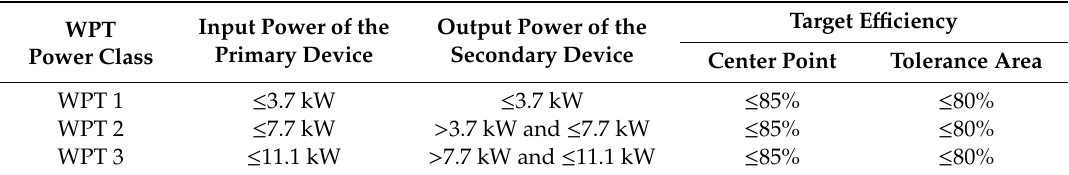
Table 1. Wireless power transfer (WPT) power classification with target e ffi ciency for light-duty electric vehicles